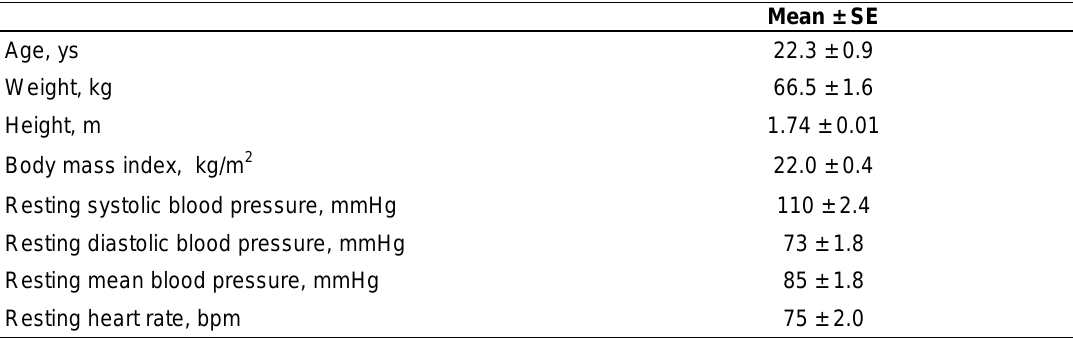
Table 1. Clinical characteristics of the